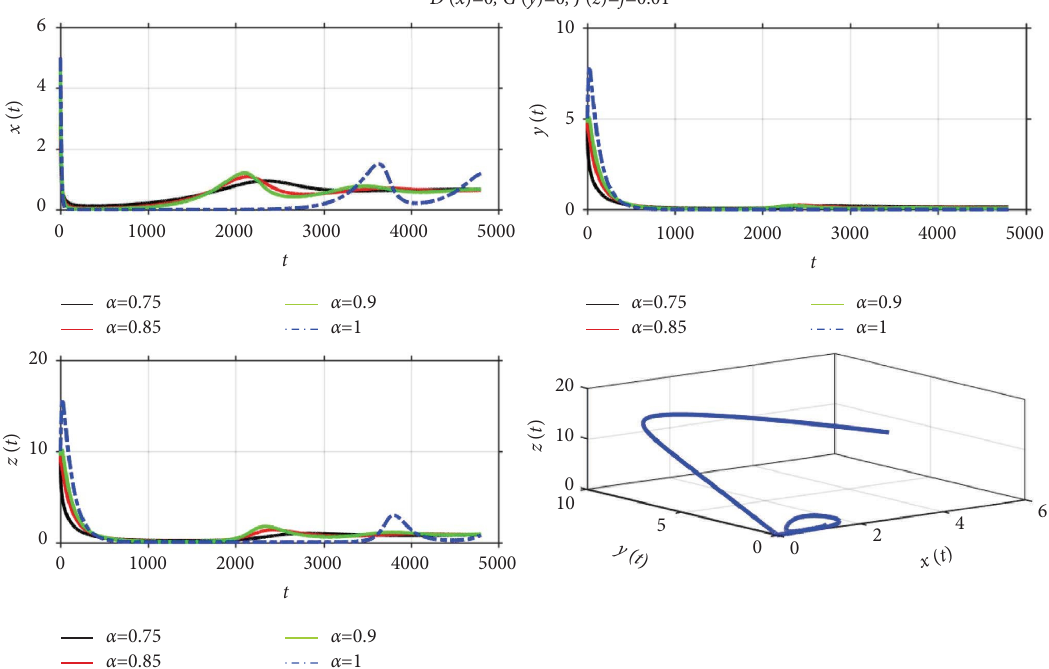
Figure 6: Population dynamics of the one prey-two predators system with D ( x ) � 0 , G ( y ) � 0 , J ( z ) � j � 0 . 01 , a � b � c � 0 . 1 , e � h � 0 . 3 , f � i � 0 . 2 , α � 0 . 75 , 0 . 85 , 0 . 9 , 1 , and 3D-plot of x ( t ) , y ( t ) , and z ( t ) for α � 1 .